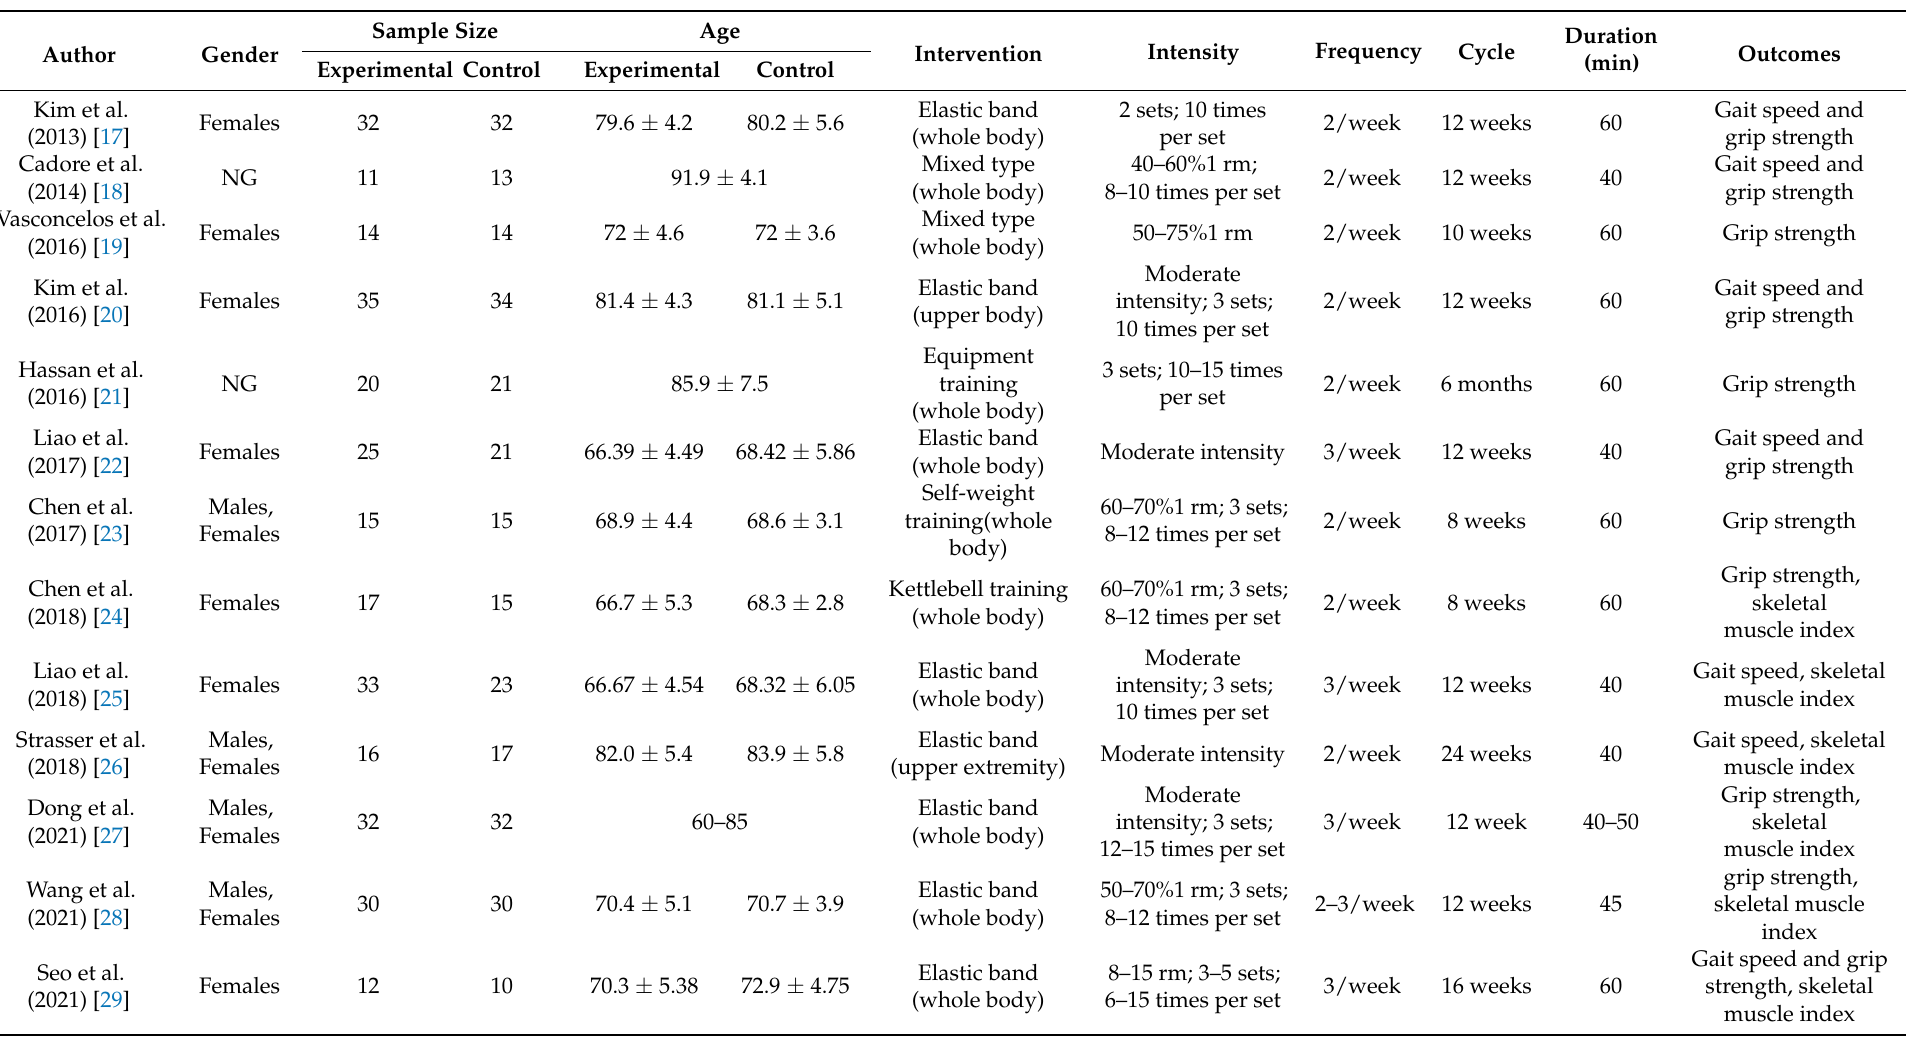
Table 1. General features of selected research